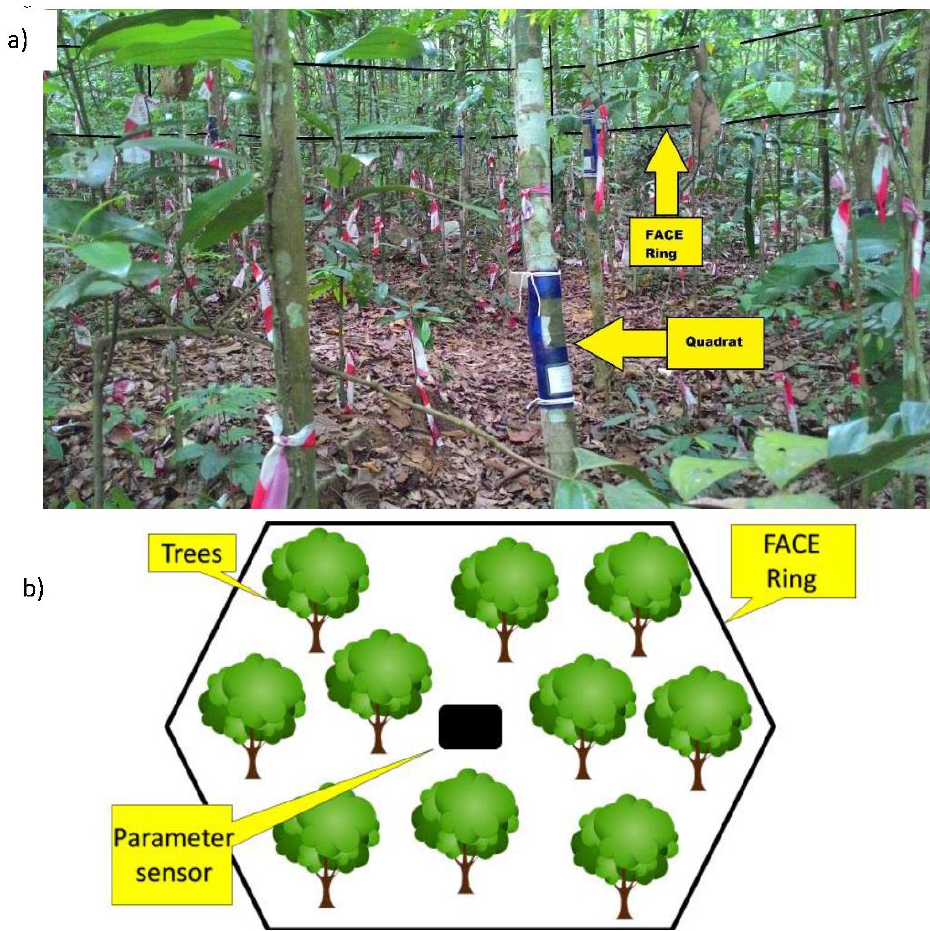
Figure 1. ( a ) Quadrats on trees in the Free-Air-Carbon Dioxide-Enrichment (FACE) system; inner (2 m, 400 ppm), middle (4 m, 440 ppm) and outer (5 m, 630 ppm). ( b ) Overall layout design of the FACE system.